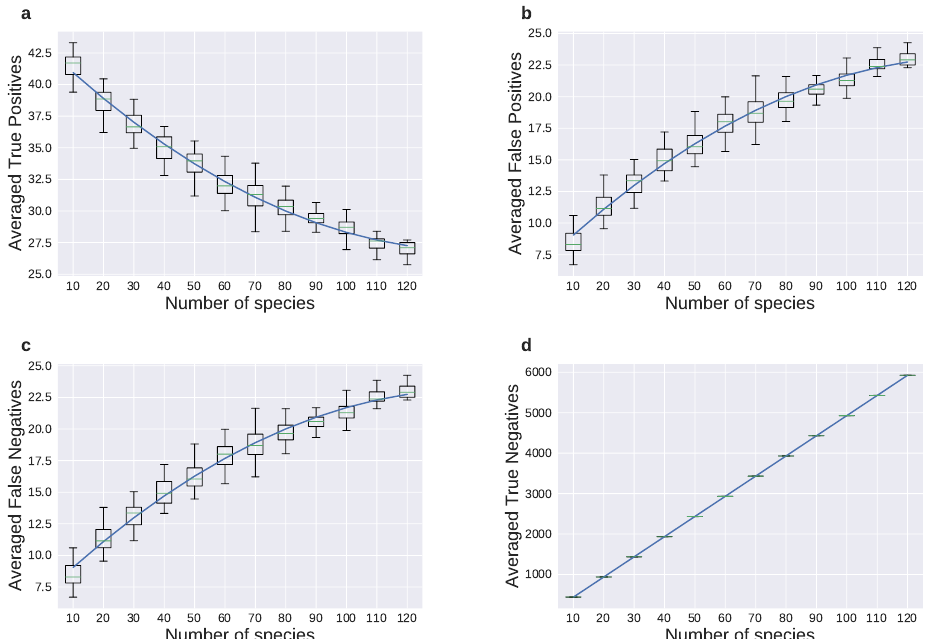
Figure 5. The elements of a confusion matrix ( a ) averaged numbers of true positives, ( b ) averaged numbers of false positives, ( c ) averaged numbers of false negatives, ( d ) averaged numbers of true negatives) display a linear (true negatives) and quadratic (all other elements) dependence on n . The error bars (whiskers) represent the ranges from the best result to worst result obtained for 20 different randomly drawn subsets for each value of n . The green marking in each box indicates the median, and the boxes show the range of the middle 50% of the